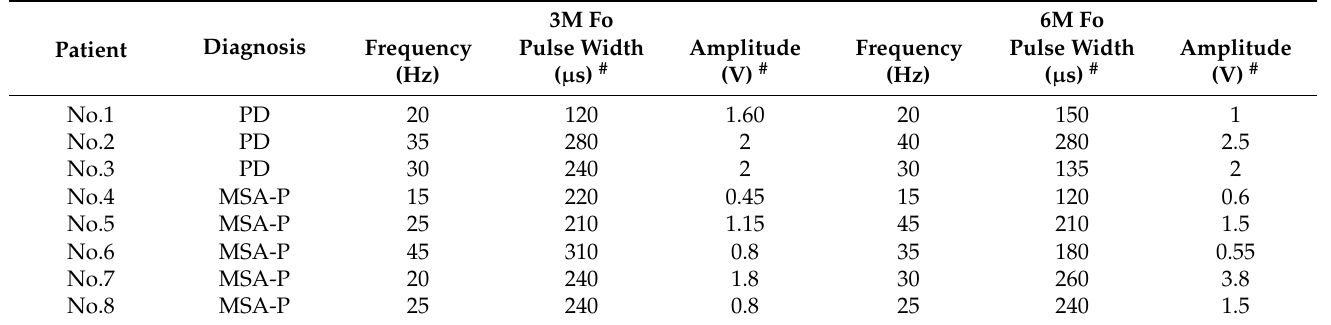
Table 2. Changes in stimulation parameters over different follow-up